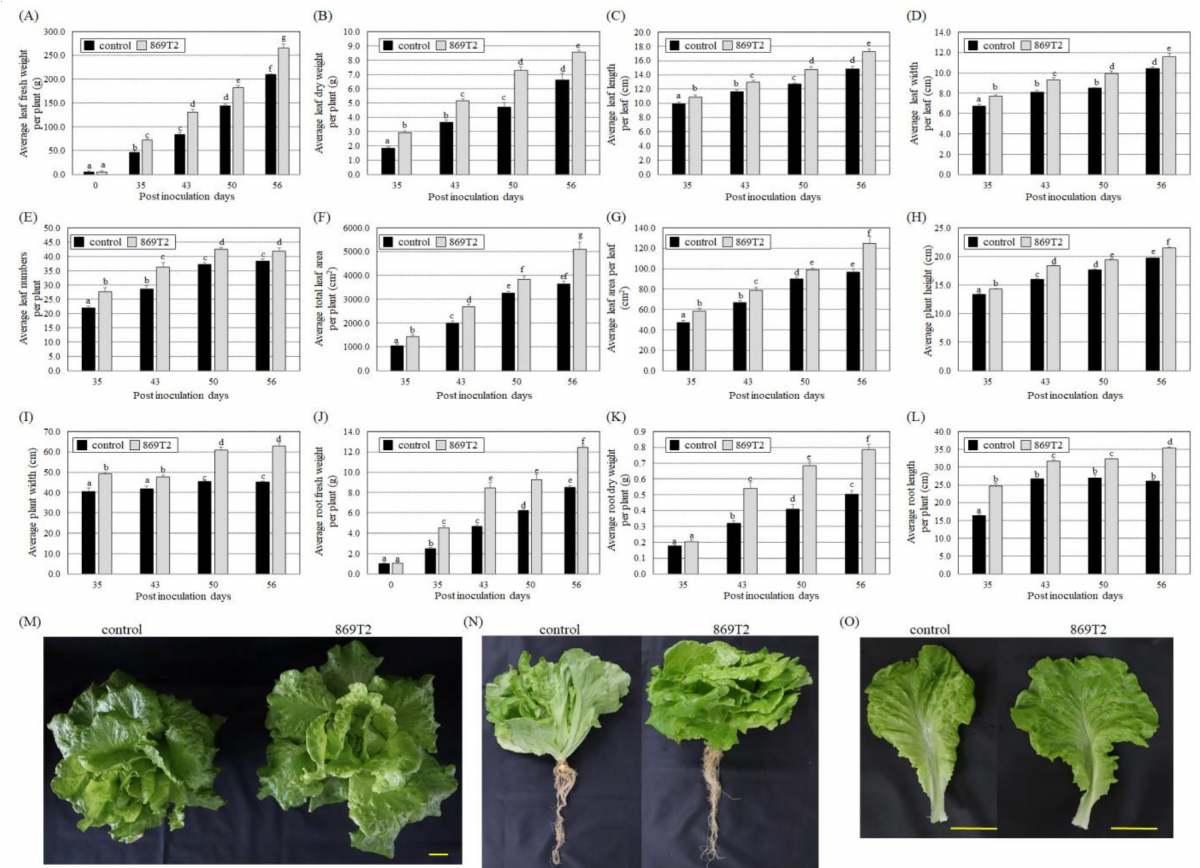
Figure 4. Loose-leaf lettuce ( Lactuca sativa L.) plants were larger and heavier after inoculation with B. seminalis strain 869T2. At 35, 43, 50, and 56 days after inoculation, the average values for leaf fresh weight ( A ), leaf dry weight ( B ), leaf length ( C ), leaf width ( D ), number of leaves ( E ), total leaf area per plant ( F ), leaf area per leaf ( G ), plant height ( H ), plant width ( I ),